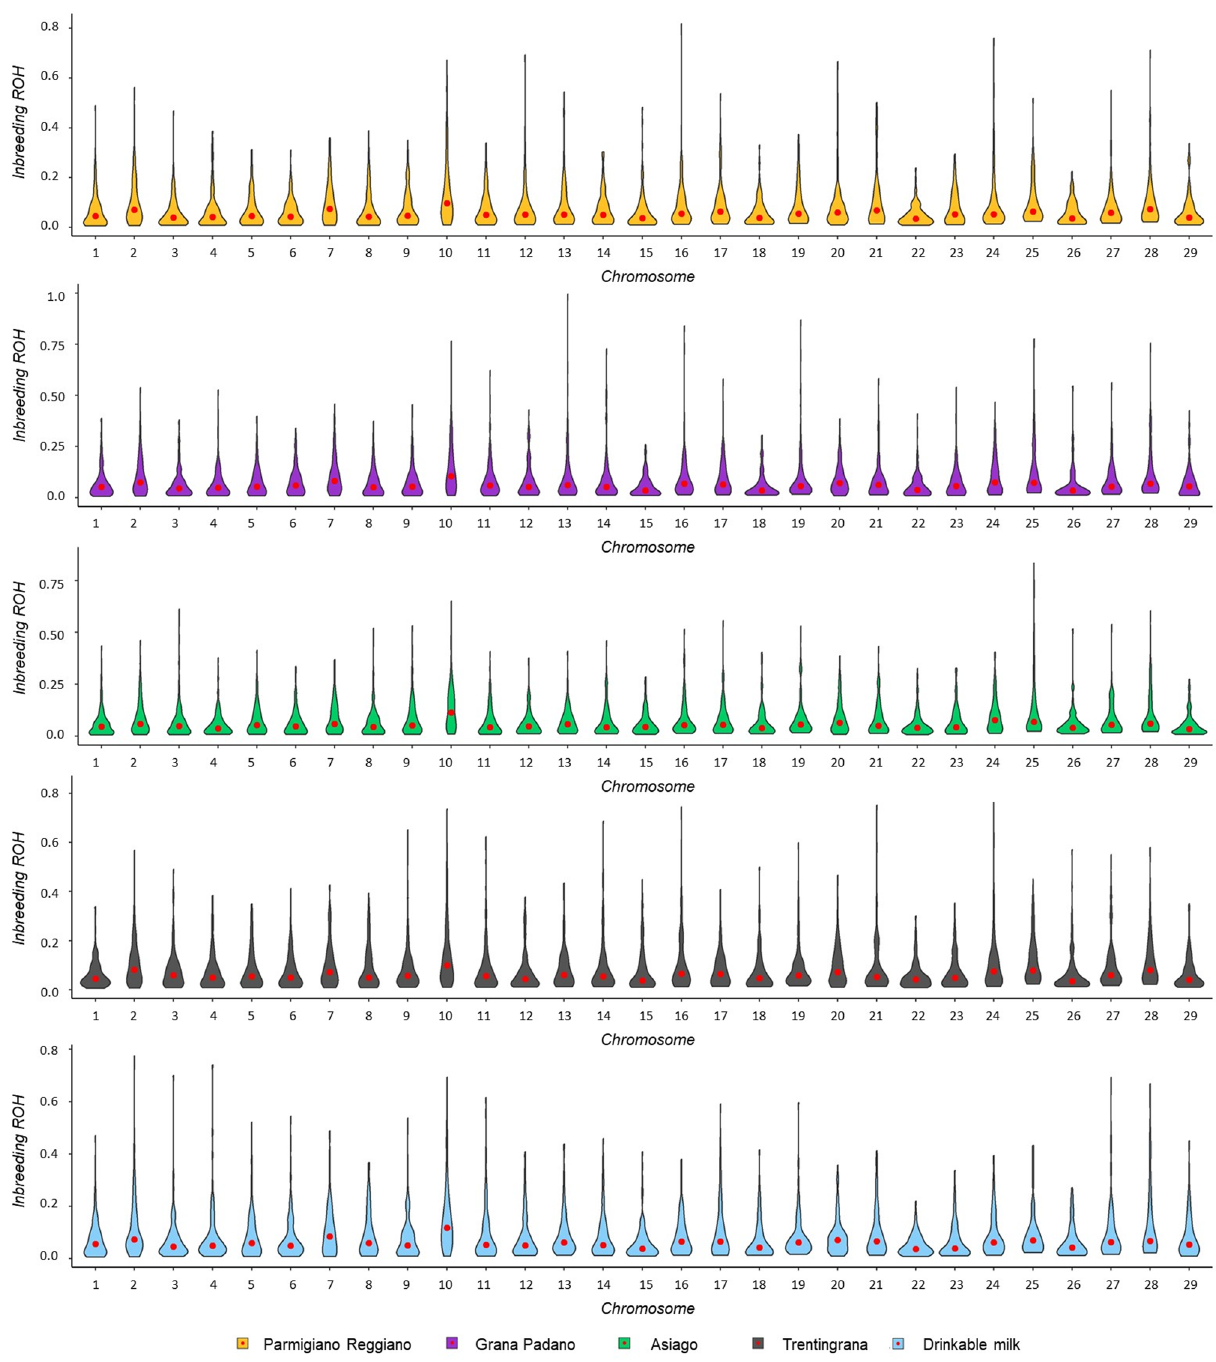
Figure 2. Summary of genomic inbreeding coefficients per chromosome (Chr_) in each subgroup. The average value is highlighted as a red